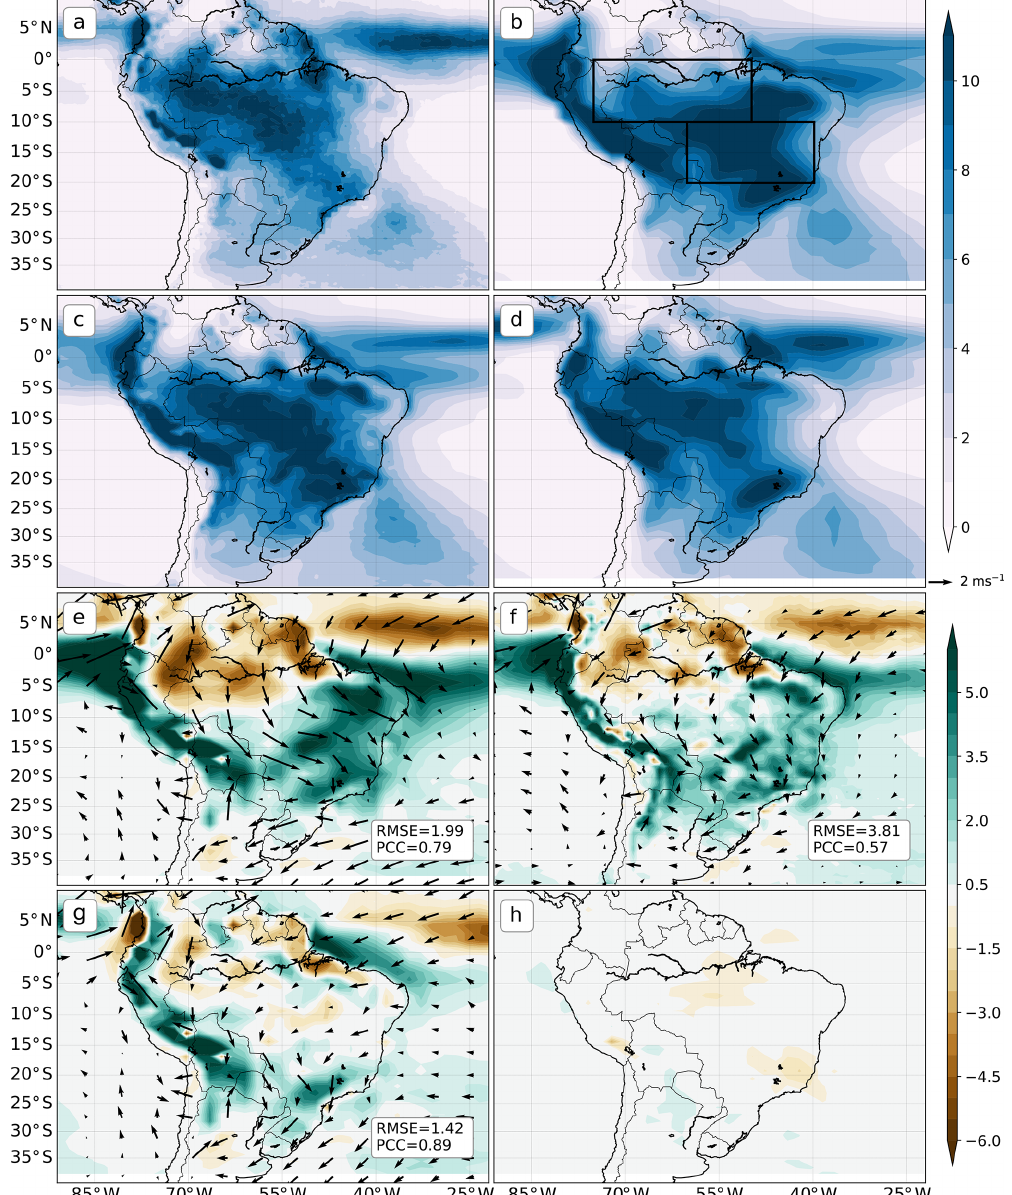
Figure 6. DJF mean rainfall (mmd − 1 ) from (a) TRMM, (b) UKESM1-historical, (c) GC3 n216 and (d) GC3 AMIP. Panels (e) , (f) and (g) show the statistically significant differences between panels (b) , (c) and (d) , respectively, and TRMM. (h) Precipitation difference between UKESM-historical and UKESM1-pi; only statistically significant difference (95%) confidence level is